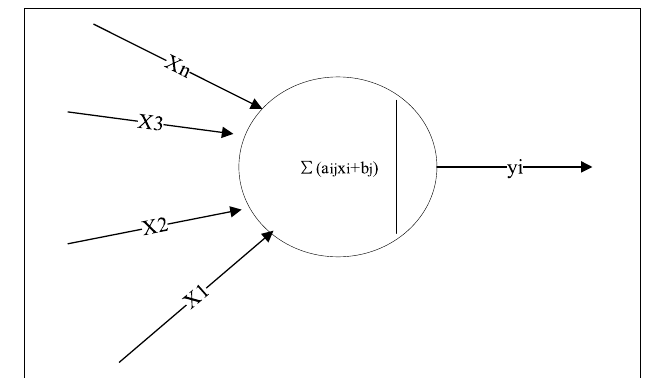
FIGURE 1 | Structure of a neuron.